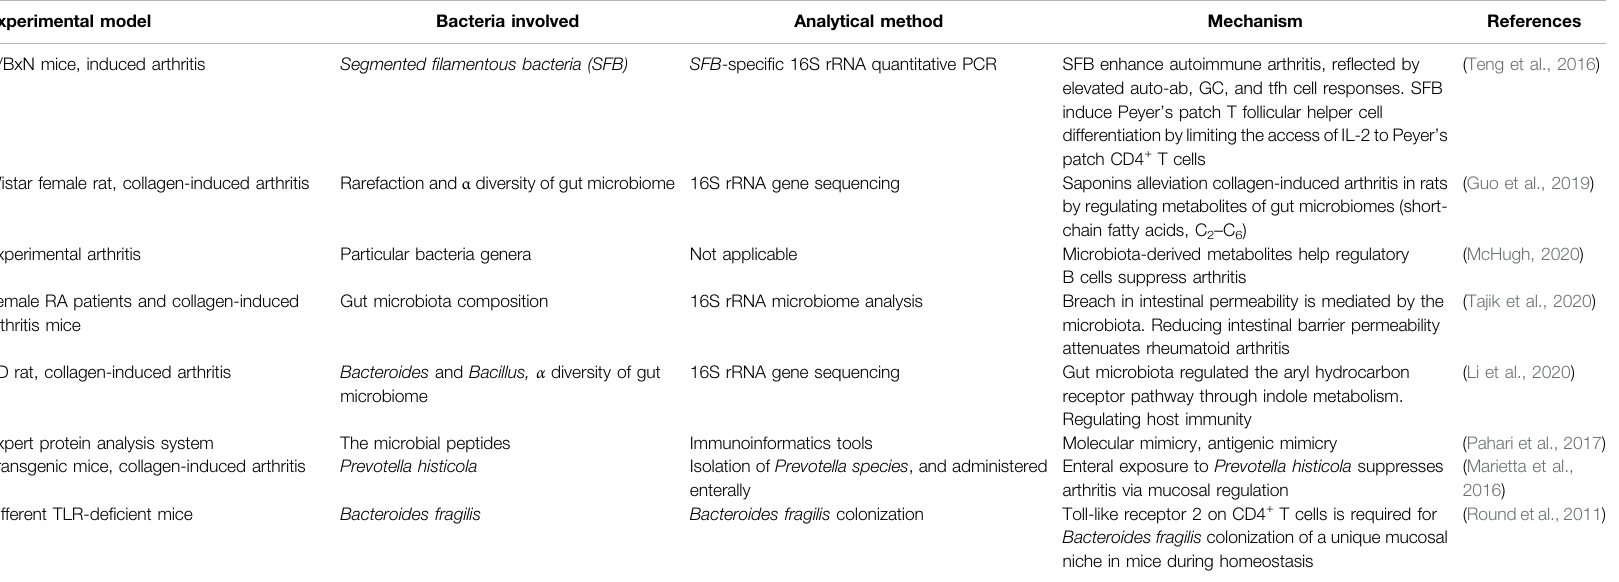
TABLE 1 | The mechanism of gut microbiome in RA (animal